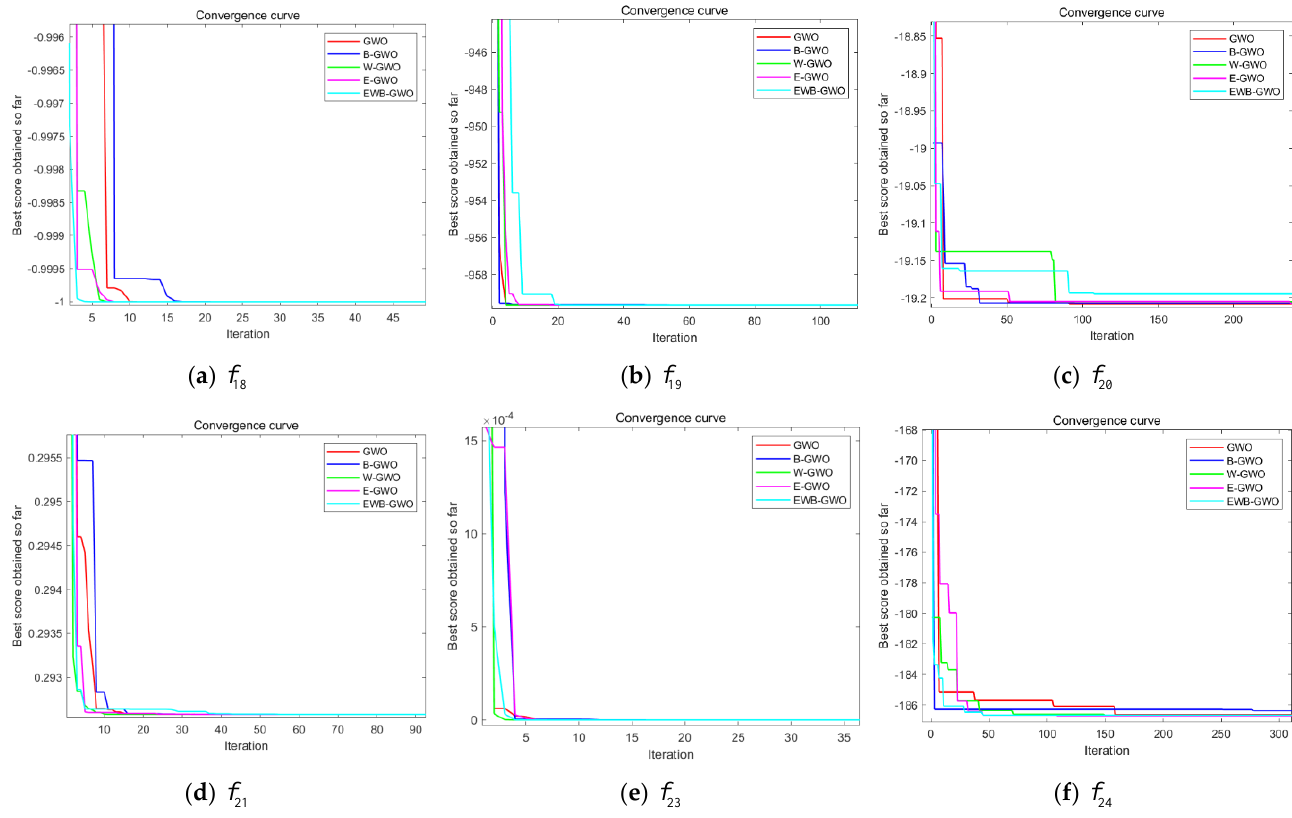
Figure 12. Comparison of convergence curves of GWO, E − GWO, W − GWO, B − GWO, and EWB − GWO in fixed-dimensional multimodal function tests. Table 3. Test results of the algorithm at Dim =